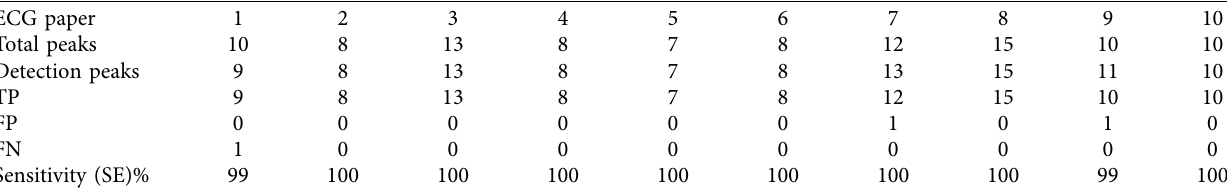
Table 2: Performance of FFT algorithm for R peaks